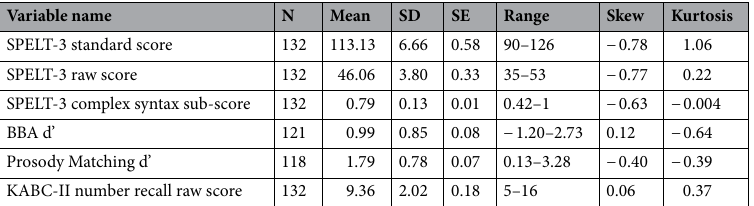
Table 2. Descriptive statistics of behavioural outcome measures. Age-normed standard scores and raw test scores for the expressive language test (SPELT-3) are shown. The complex syntax sub-score is a non-scaled raw score. The d’ dcalculated using signal detection is reported for the BBA and Prosody Matching tests. The non- scaled raw score of the forward digit span subtest of the KABC-II is used. SPELT-3 = Structured Photographic Expressive Language Test-3; BBA = Beat-Based Advantage; KABC = Kaufman Assessment Battery for Children.